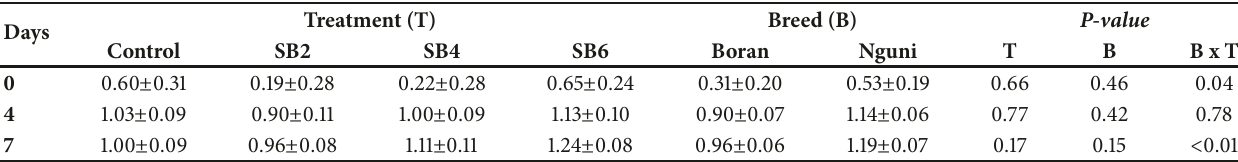
Table 4: Preservative effect of sweet basil essential oil on oxidative stability of minced beef from Boran and Nguni cattle during cold storage at 4 ∘